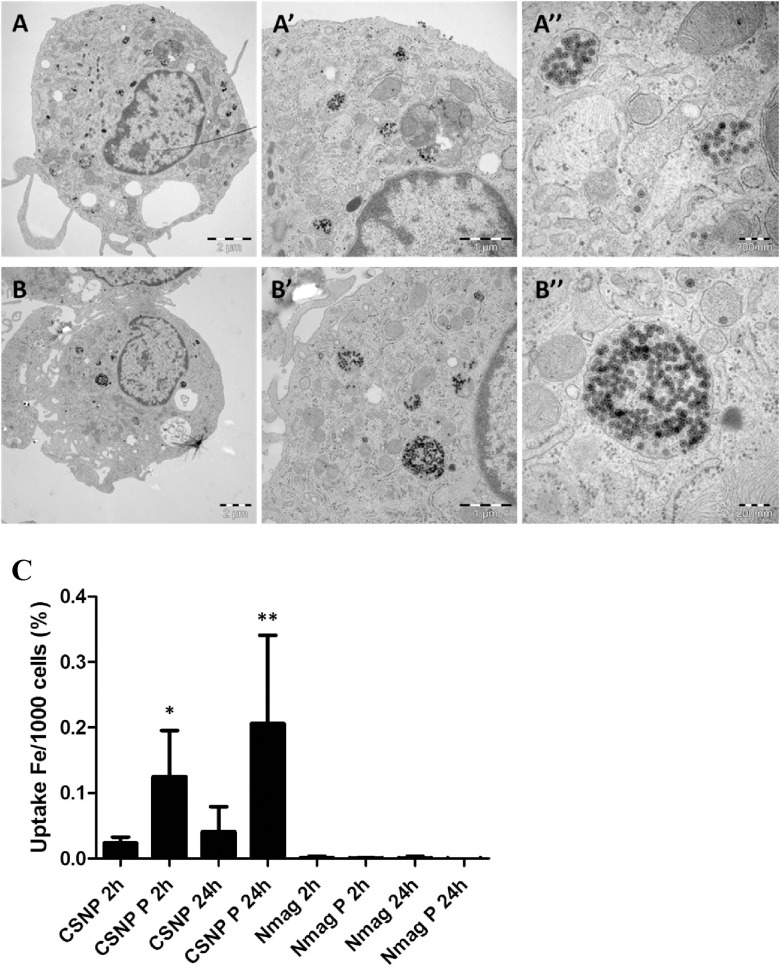
Macrophage internalization of SPIONs with or without a protein corona.TEM of HMDM exposed for 2 h to 50 μg/ml of CSNP (A-A”) or to CSNP + protein corona (B-B”). The arrows in (A, B) and (A’, B’) show some of the areas where the nanoparticles are located in the cells. In the higher magnification micrographs (A”, B”) the core-shell nanoparticles can be clearly seen. C. Uptake of CSNP, CSNP + protein corona, nanomag-D-spio, and nanomag-D-spio + protein corona was quantified by using ICP-MS to determine cellular iron content. HMDM were exposed to 50 μg/ml SPIONs for 2 h and 24 h. Results are presented as % of iron concentration per 1000 cells (mean values ± S.D.) adjusted to control, from three independent experiments, using cells from healthy donors. HMDM were maintained in cell culture medium without FBS. The difference in degree of cellular uptake between the two SPIONs in the absence or presence of a protein corona was evaluated using Tukey post-hoc test following one way ANOVA (*p<0.05,**p<0.01).